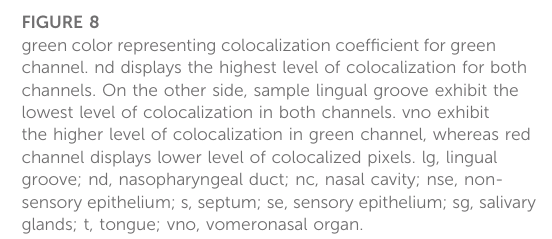
FIGURE 8 green color representing colocalization coef fi cient for green channel. nd displays the highest level of colocalization for both channels. On the other side, sample lingual groove exhibit the lowest level of colocalization in both channels. vno exhibit the higher level of colocalization in green channel, whereas red channel displays lower level of colocalized pixels. lg, lingual groove; nd, nasopharyngeal duct; nc, nasal cavity; nse,